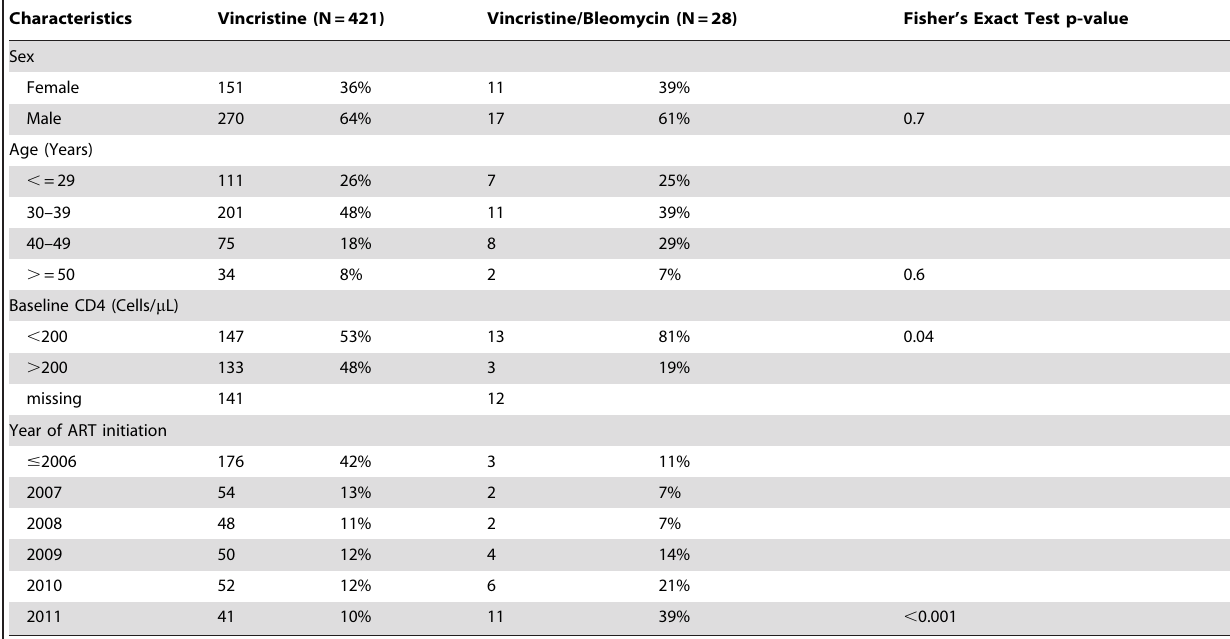
Table 1. Baseline characteristics.